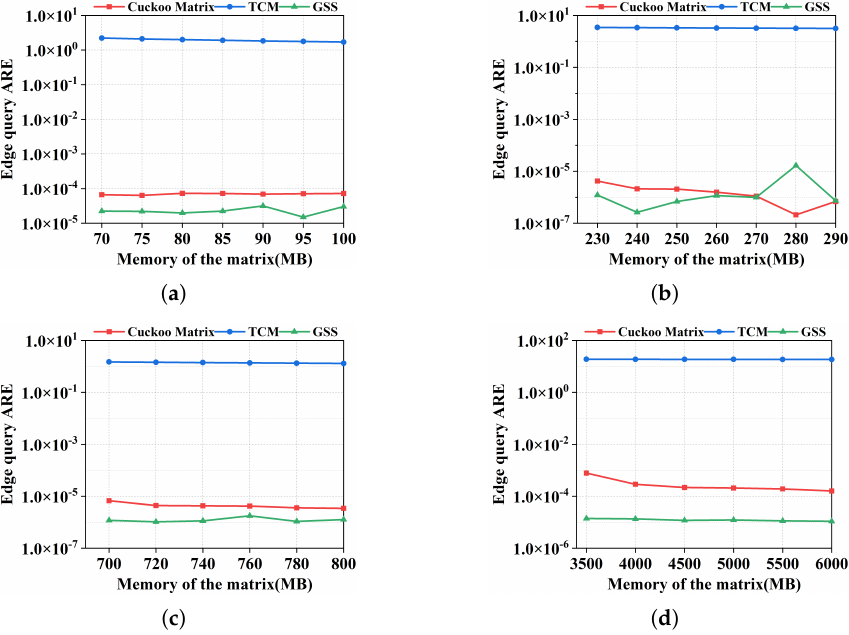
Figure 4. Average relative error of edge queries. ( a ) Skitter. ( b ) DBLP. ( c ) Orkut. ( d )